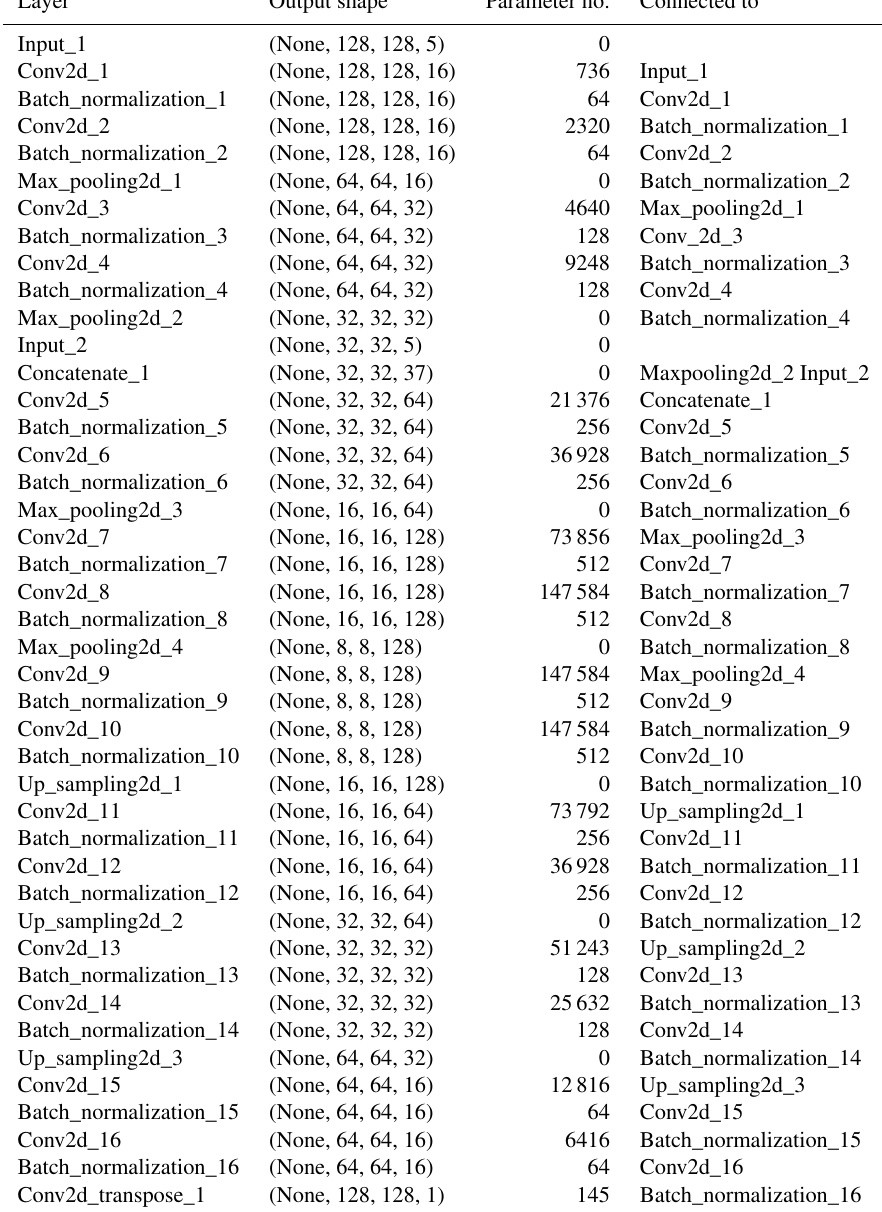
Table A1. Model summary of the encoder–decoder